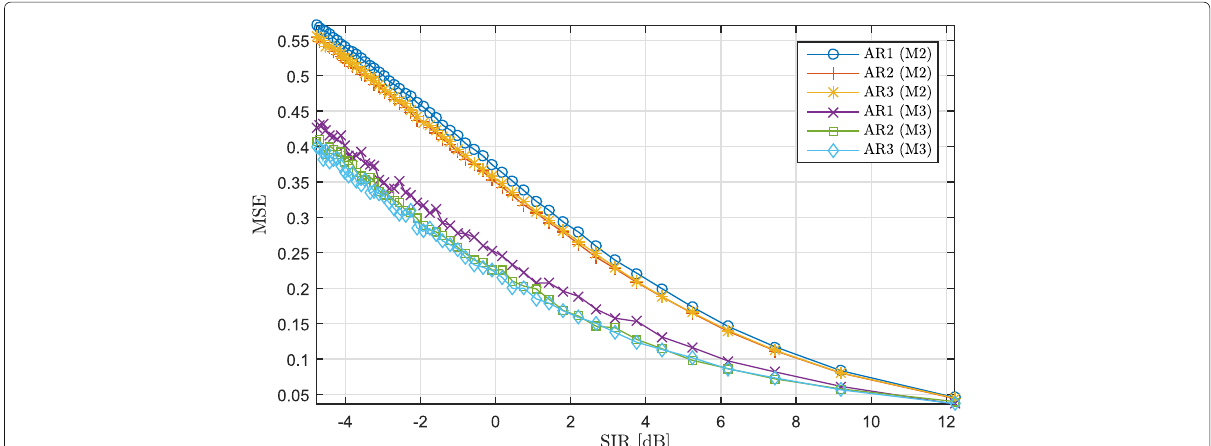
Fig. 14 Comparison of different AR model orders when using M2 and M3 mobility